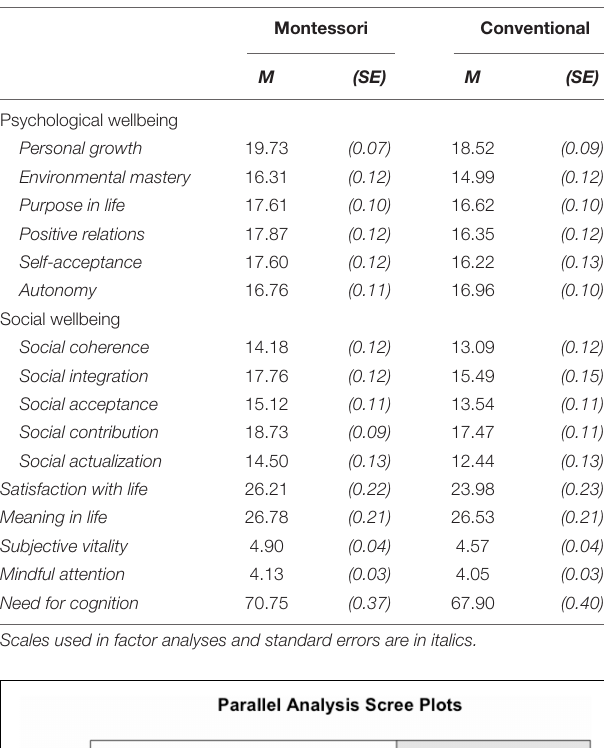
TABLE 1B | Means, SDs, and/or percentages for demographic variables for the Montessori and conventional samples.